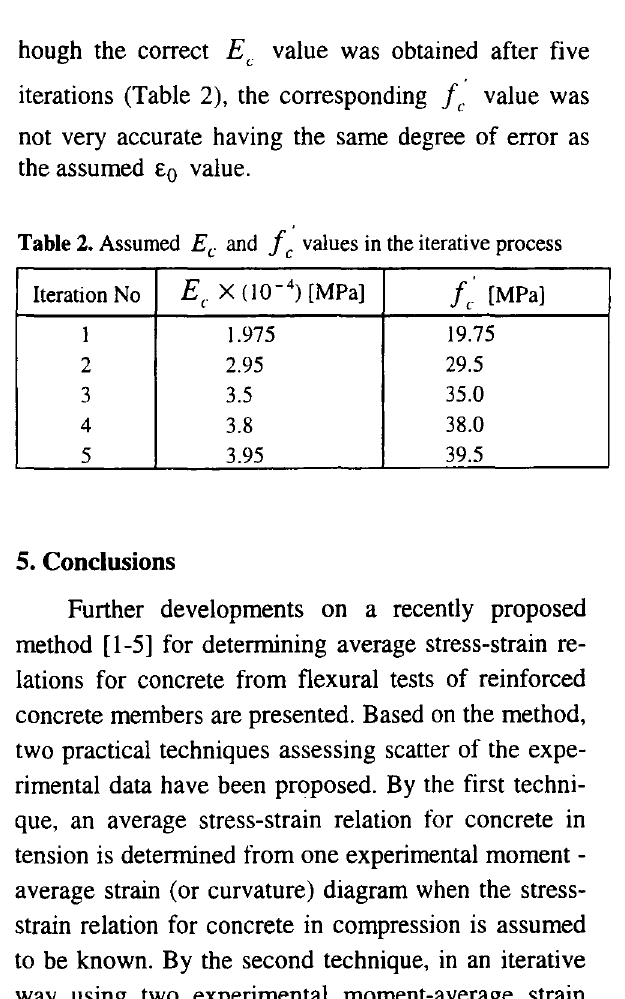
Table 2. Assumed Ec and fc' values in the iterative process Iteration